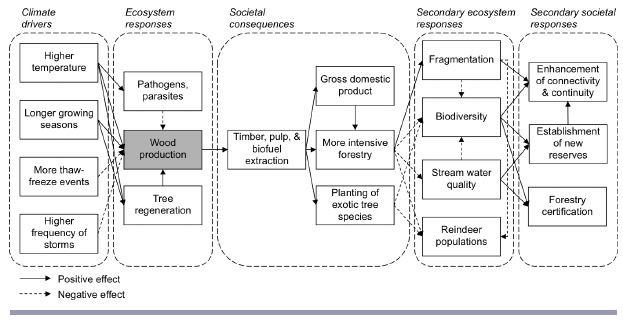
Fig. 3 . Conceptual model of the cause-and-effect relationships expected as a result of climate change for one ecosystem service, wood production (shaded box). Solid arrows indicate positive, enhancing effects, whereas dashed arrows indicate negative effects